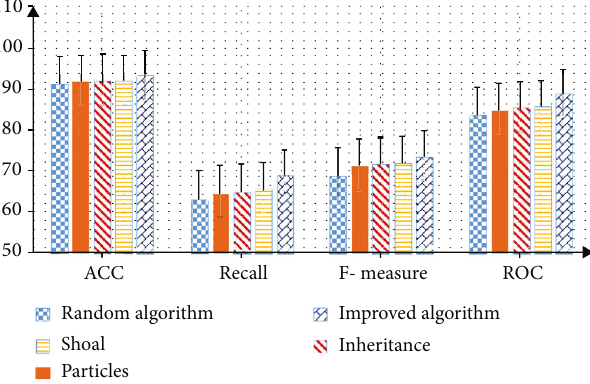
Figure 5: Performance comparison of di ff erent algorithms.